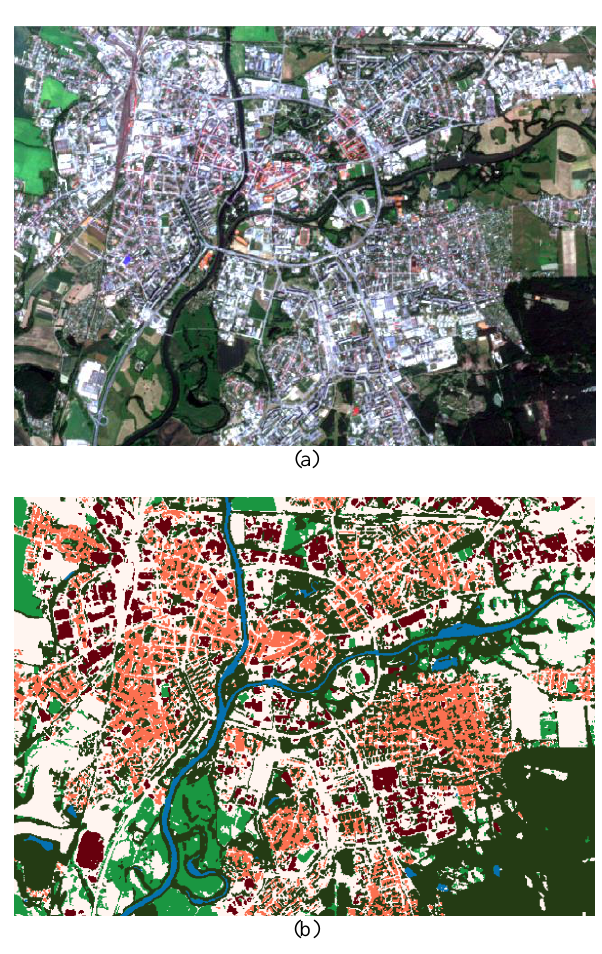
Figure 16: (a) Sentinel-2-derived 10-m image over Hradec Kralove, Czech Republic, and (b) corresponding 6-classes landcover map: water (blue), grass (green), tree/forest (dark green), residential building (orange), industrial/commercial building (brown) and barren